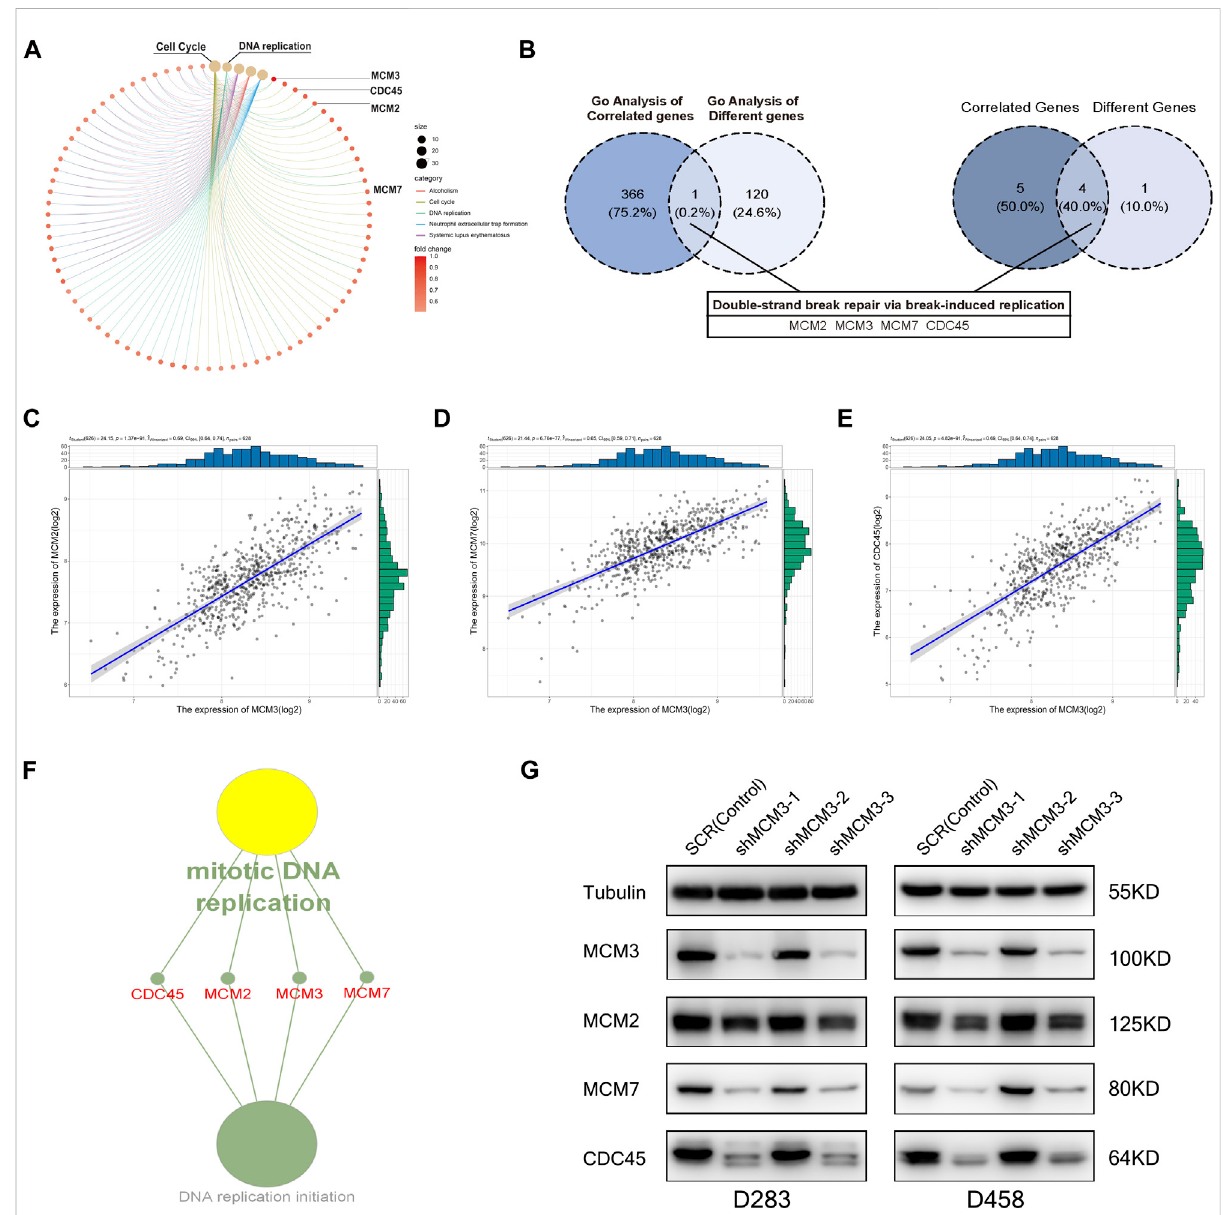
FIGURE 3 GO enrichment analysis of DEGs for different MCM3 expression levels showing the dysregulation of the cell cycle and DNA replication (A) . GO analysis of MCM3-correlated genes and DEGs revealed overlap only for “ Double-strand break repair via break-induced replication ” , with only four genes in this biological process differentially expressed and signi fi cantly correlated with MCM3 (B) . Signi fi cant correlations of MCM3 with MCM2, MCM7, and CDC45 were (C – E) . MCM2, MCM3, MCM7, and CDC45 are the main components of the pre-replicative complex (F) . MCM7 and CDC45 are correlated with MCM3 at the protein level via WB analysis in D283 and D458 cell lines (G)